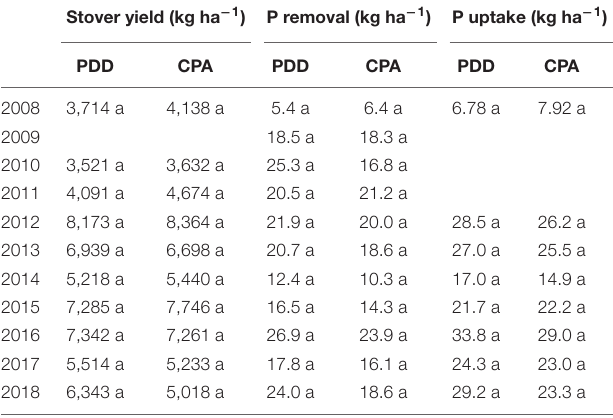
TABLE 2 | Corn (2008, 2010, 2012, 2014, 2016, and 2018) and soybean (2009, 2011, 2013, 2015, and 2017) stover yields, P removal (i.e., P contained in grain), and uptake (i.e., P contained in all aboveground biomass and grains) with continuous fertilizer P addition (CPA) and soil P draw-down